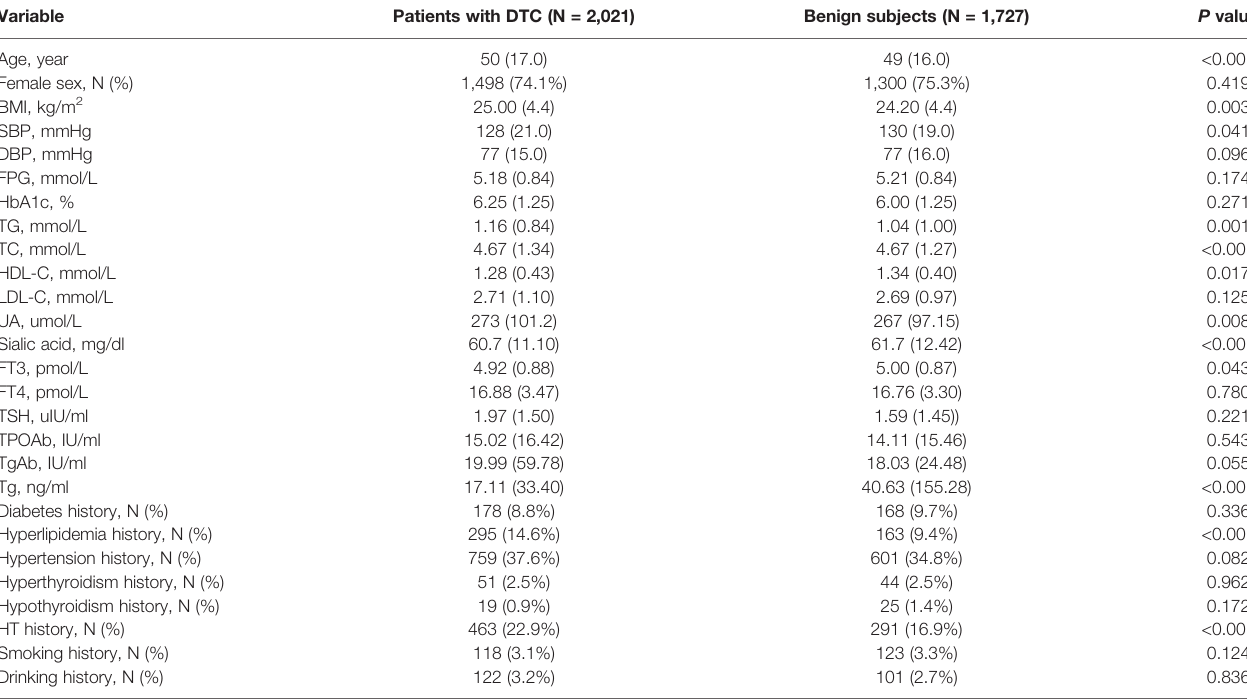
TABLE 1 | Main characteristics of the study population*. Variable Patients with DTC (N =